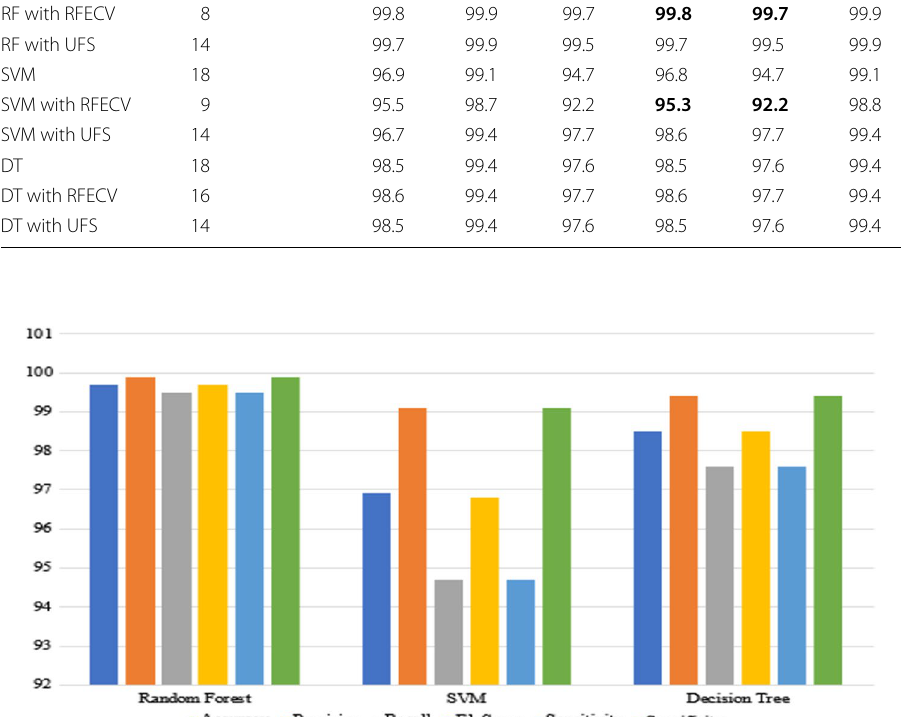
Fig. 7 Binary class classification without feature